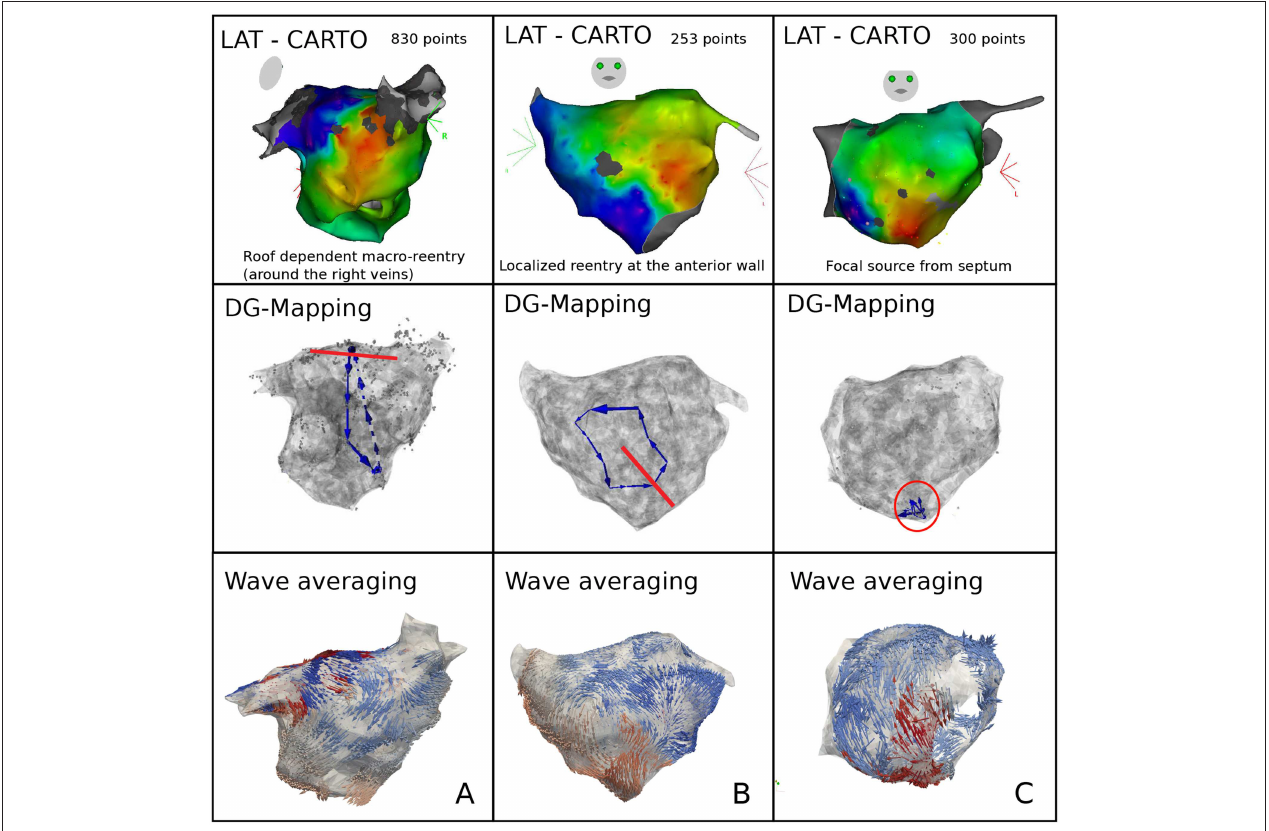
FIGURE 6 | Representative examples of DG mapping in 3 cases of clinical AT: macro-reentry (A) , localized reentry (B) , and a focal source (C) . For each case, the activation map (top), the corresponding DG-map whereby the ablation target is indicated in red (middle) and the network based wave averaging (bottom) are